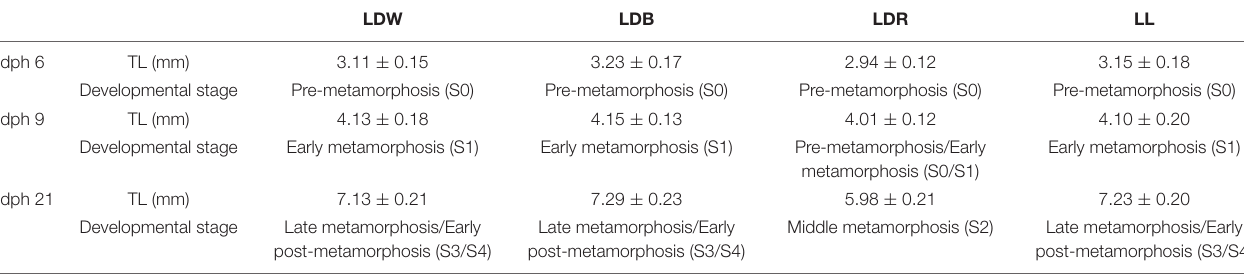
TABLE 1 | Total length (TL) and main developmental stages of Senegalese sole under the different light regimes